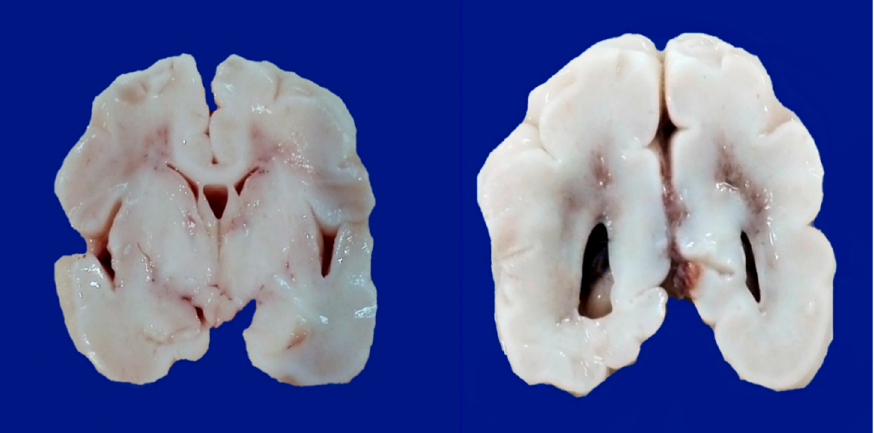
Figure 4. Periventricular white matter greyish discoloration and edema in a male, 32 weeks of gestational age old, with HIE. (Courtesy: Mar í a de Lourdes Cabrera-Muñoz, MD, Department of Pathology, Hospital Infantil de M é xico Federico G ó mez).